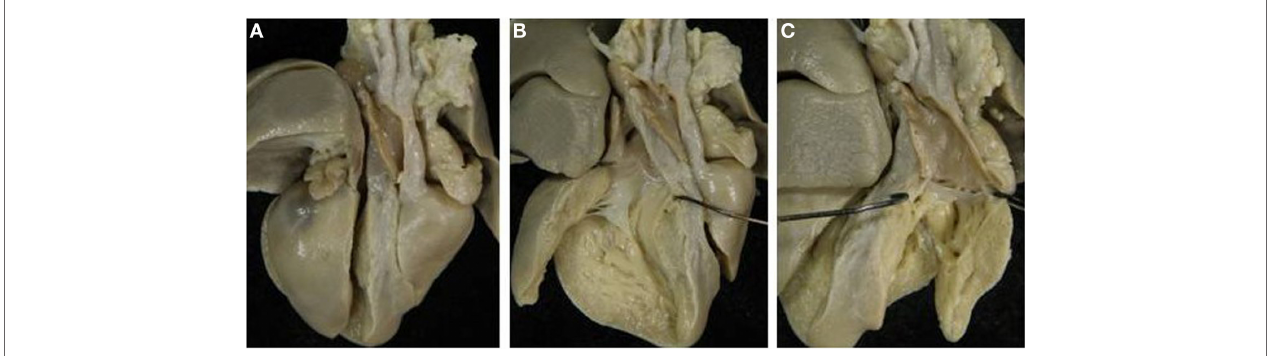
FigUre 9 | complete Tga in situs inversus . (a) External view of the heart with dextrocardia and left position of the aorta. (B) The pulmonary artery takes origin from the right-sided morphological left ventricle. (c) The aorta takes origin from the morphological right